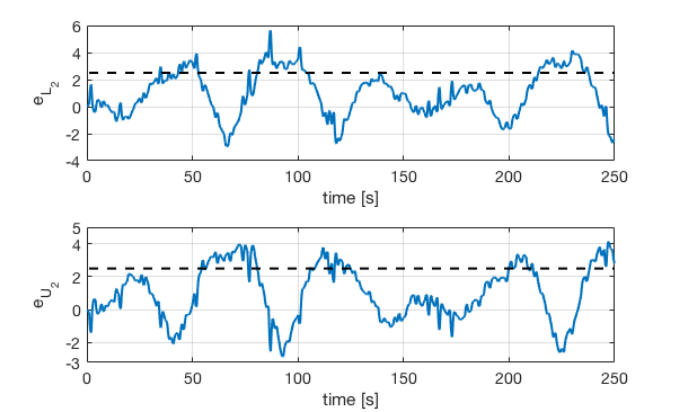
> T h before e U 2 , but the same 2